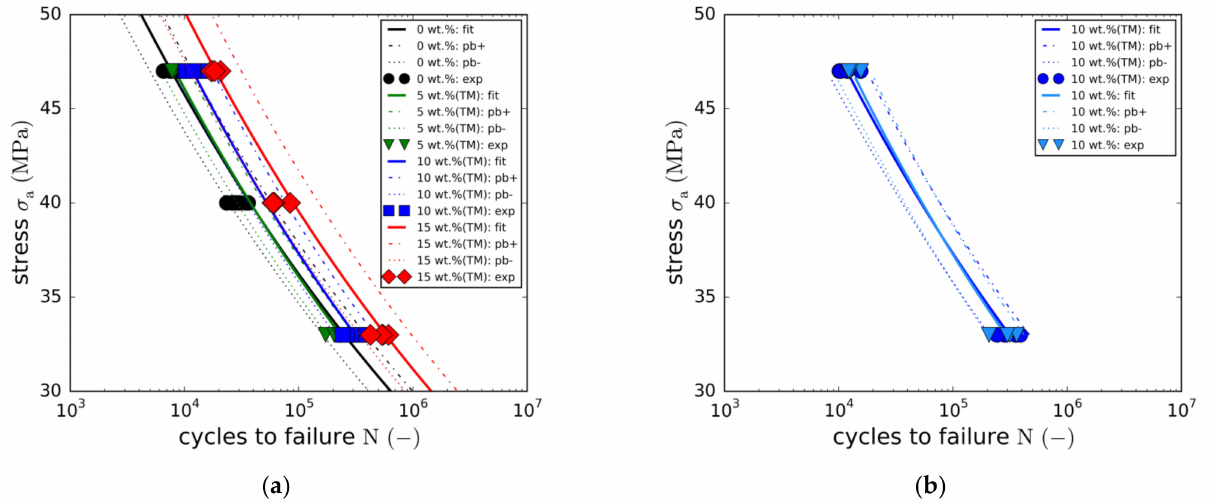
Figure 8. ( a ) Comparison of reference GFRP with 5 wt.%, 10 wt.% and 15 wt.% boehmite nanoparticles; ( b ) Effect of taurine surface modification on fatigue life.